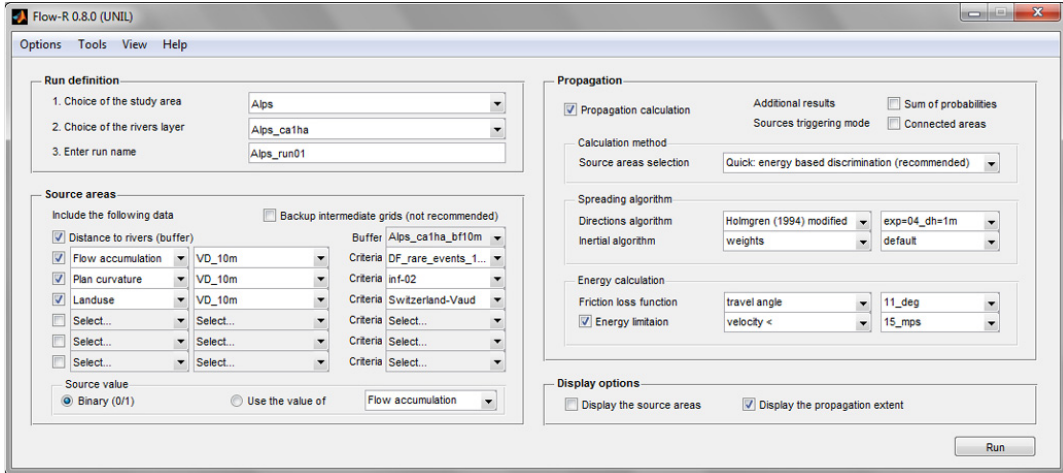
Fig. 1. Screen capture of the main frame of the Flow-R software.